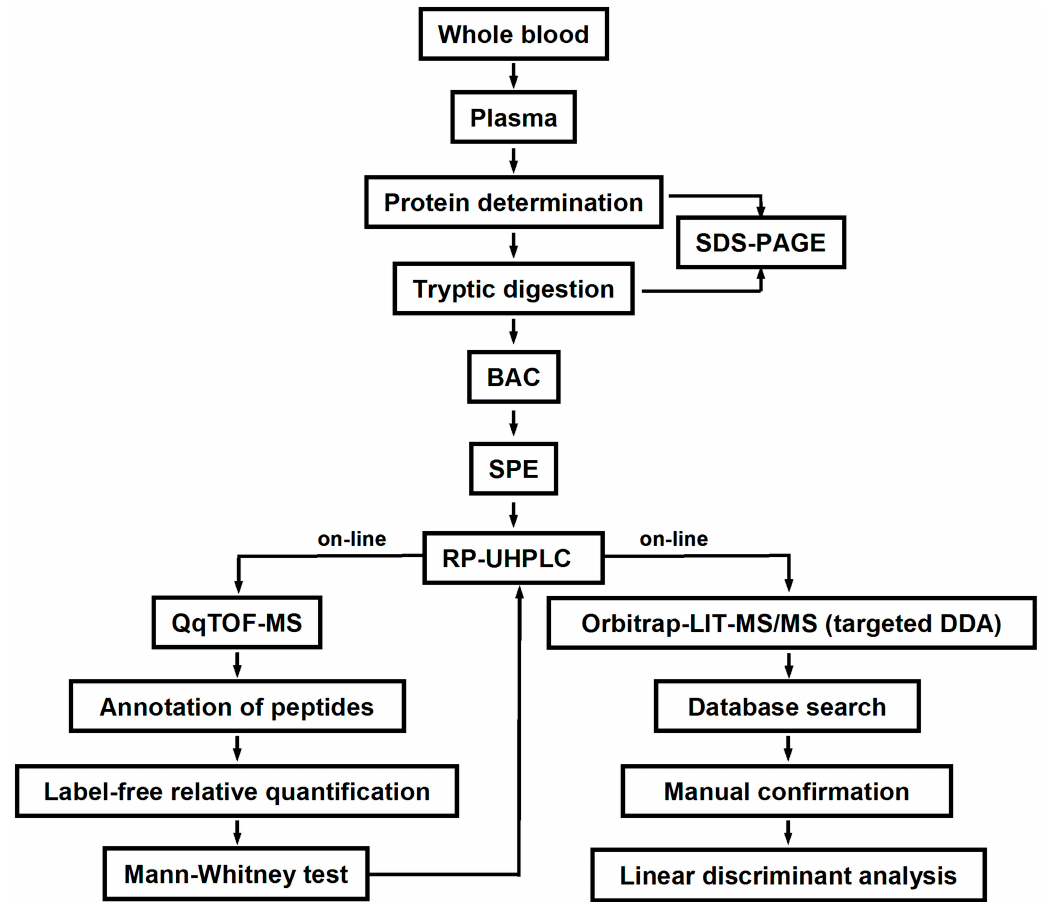
Figure 2. Overview of the experimental workflow.